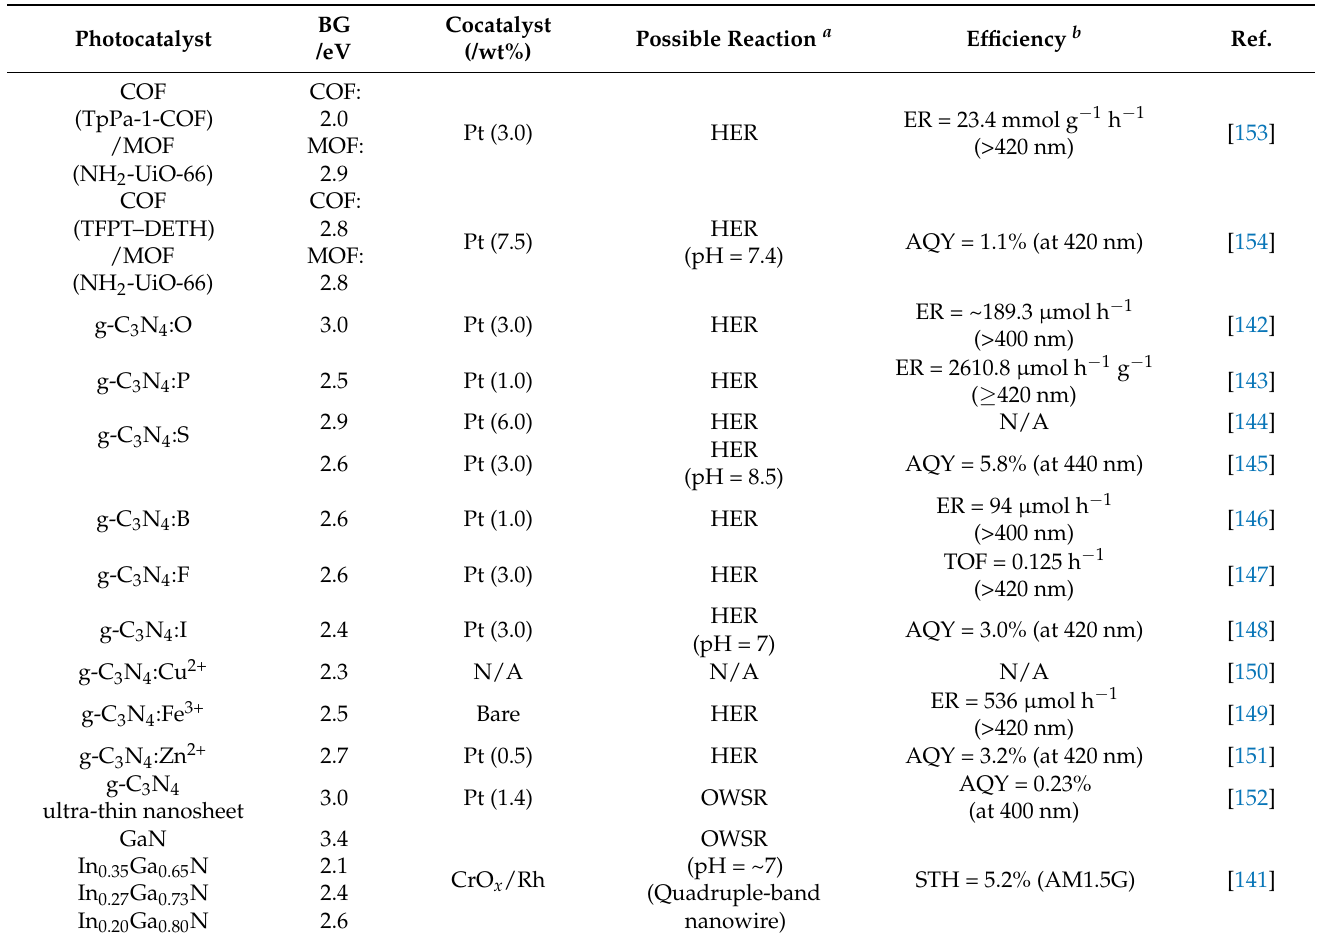
Table 2. BG, Effective cocatalysts, possible reaction, and efficiency of Vis-light-driven water-splitting photocatalysts introduced in Section